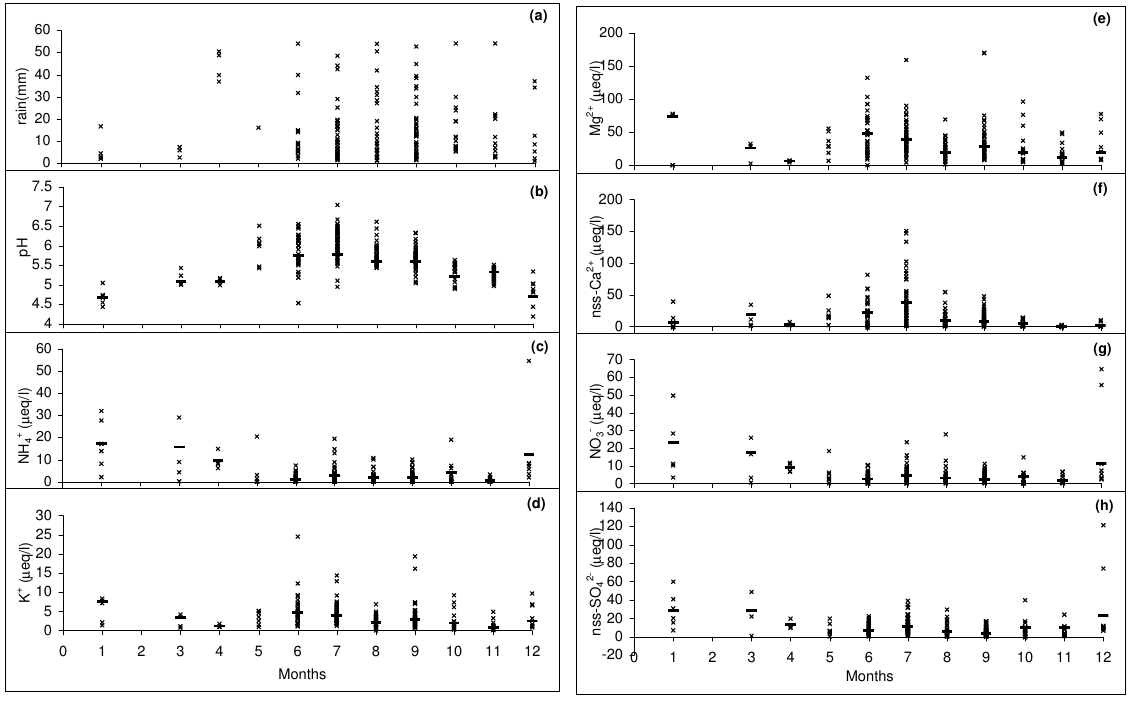
Fig. 3. Summary by month of measured quantities (a) rainfall amount (in mm), (b) pH, (c) NH + and (h) nss-SO 2 − . Also shown as horizontal lines are volume weighted monthly mean values of ionic components (in µ eq/l). 4